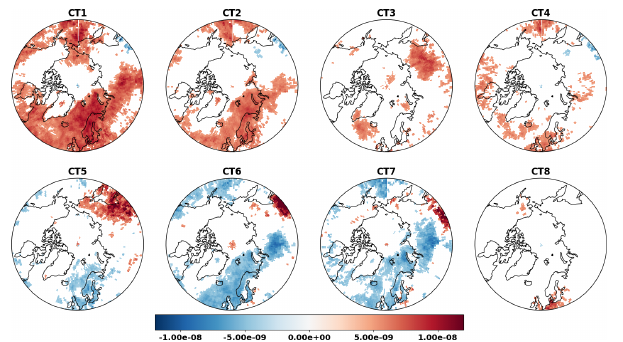
Figure 8. The 500hPa CO anomalies as volume mixing ratios based on AIRS data for the eight circulation types with 90%